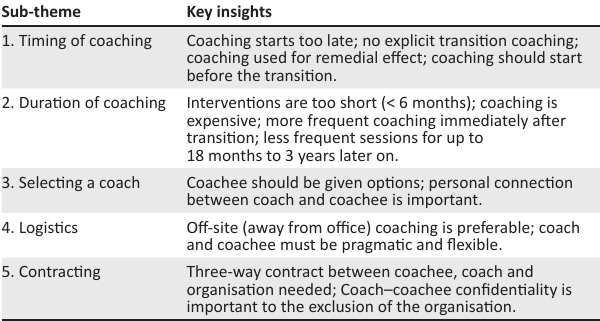
TABLE 1: Theme 1: Initiating